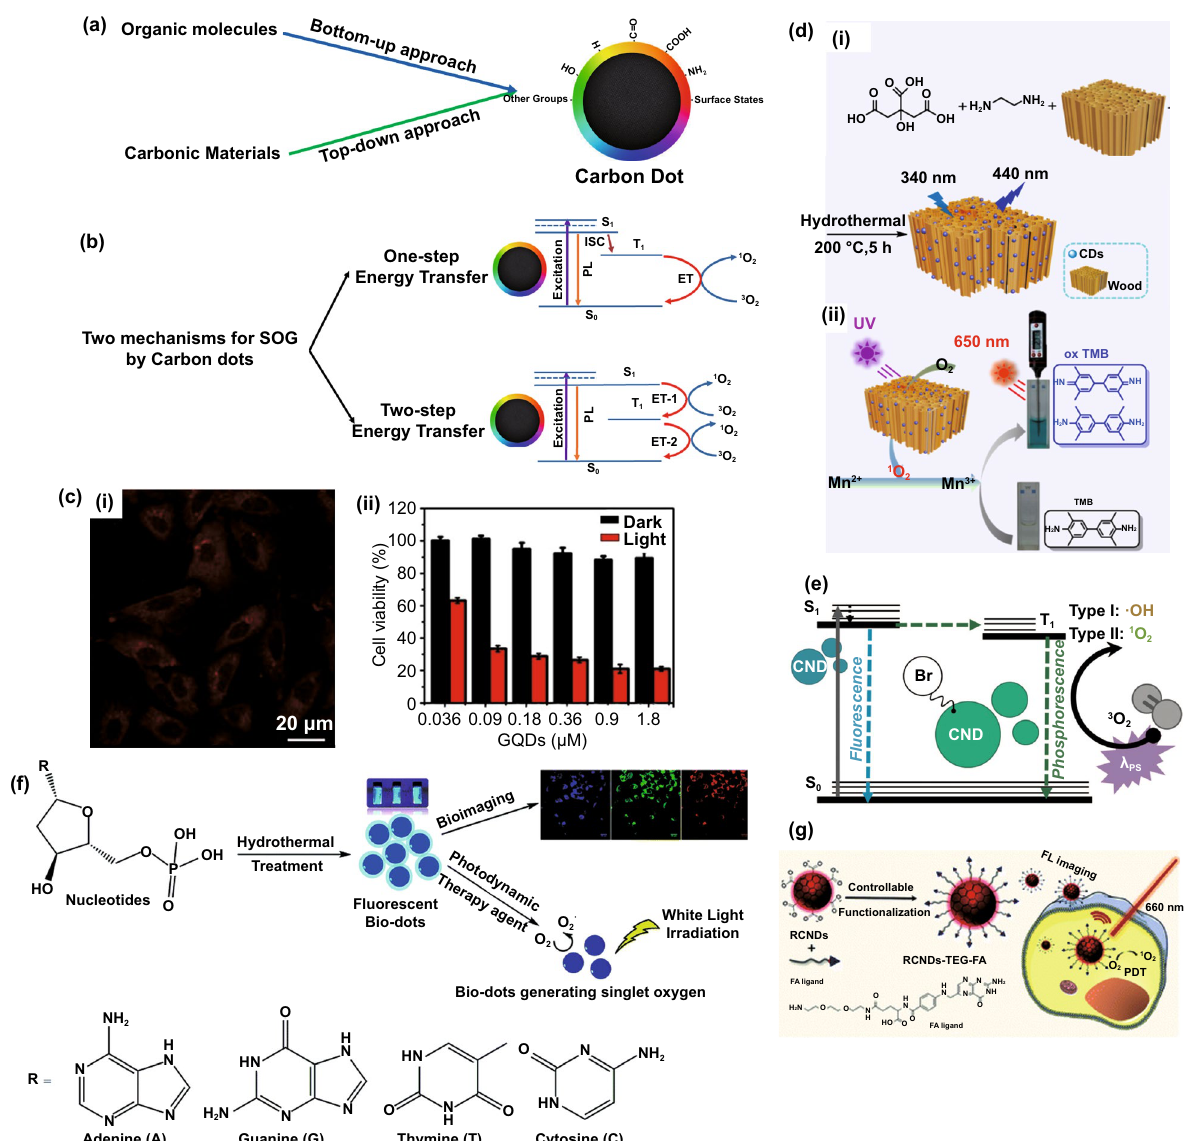
Fig. 8 a Synthesis approaches of carbon dots having different functional groups on their surface. b Different mechanisms for singlet oxygen generation by carbon dots: One-step energy transfer like common photosensitizer and two-step energy transfer mechanism proposed by Ge et al. (adapted and reproduced from Ref. [147] with permission from Springer-Nature). c Fluorescence imaging of HeLA cells and corresponding cytotoxicity effects of the graphene dots on HeLa cells, reproduced from Ref. [147] with permission from Springer-Nature, d (i) Synthesis of carbon dots confined in the wood structure, and (ii) Schematic Illustration of photothermal signal-amplified detection of Mn 2+ based on the detection system of CDs@wood and 3,3,5,5-tetramethylbenzidine, reproduced from Ref [153]. with permission from American Chemical Society. e Jablonski diagram for brominated carbon dots with ROS generation ability, reproduced from Ref. [154] with permission from Royal Society of Chemistry. f Schematic illustration of amino acids-derived biodots for fluorescence imaging and photodynamic therapy under irra- diation of visible light, reproduced from Ref. [134] with permission from Royal Society of Chemistry. g Folic acid-functionalized carbon dots synthesized from polythiophene phenylpropionic acid for fluorescence imaging and PDT under 660 nm laser, reproduced from Ref. [158] with permission from Royal Society of